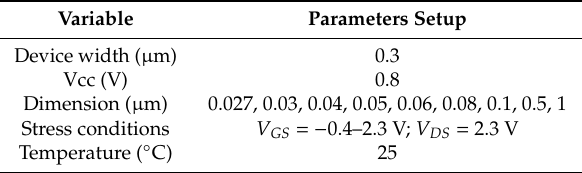
Table 2. Measurement conditions for I SUB values.